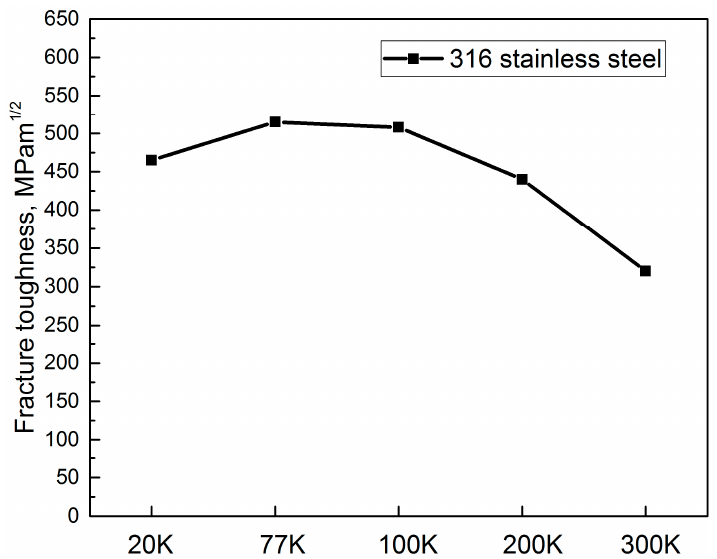
Figure 2. Cryogenic fracture toughness of 316 stainless steel at different temperatures.